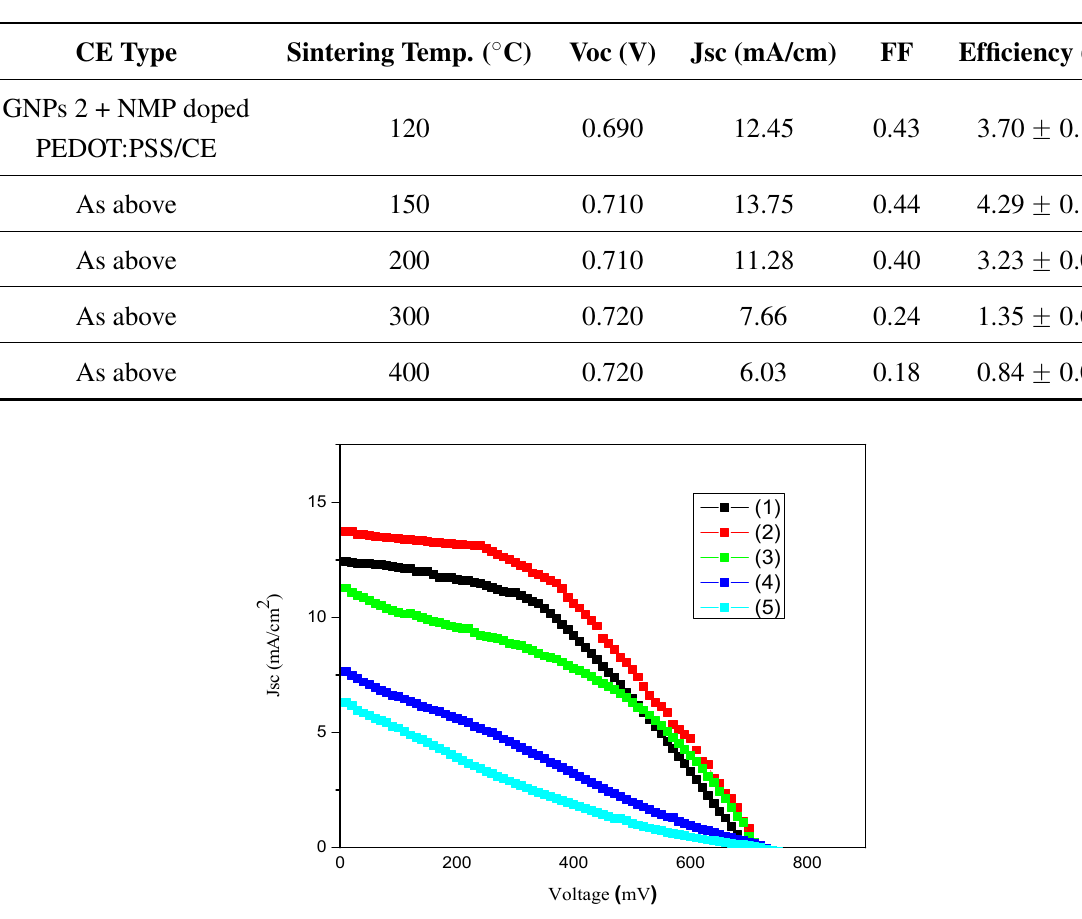
Figure 8. The photovoltaic (J–V) curves of GNPs type 2 + NMP doped PEDOT:PSS film/CE-DSSCs which were sintered at (1) 120 °C; (2) 150 °C; (3) 200 °C; (4) 300 °C; (5) 400 °C.